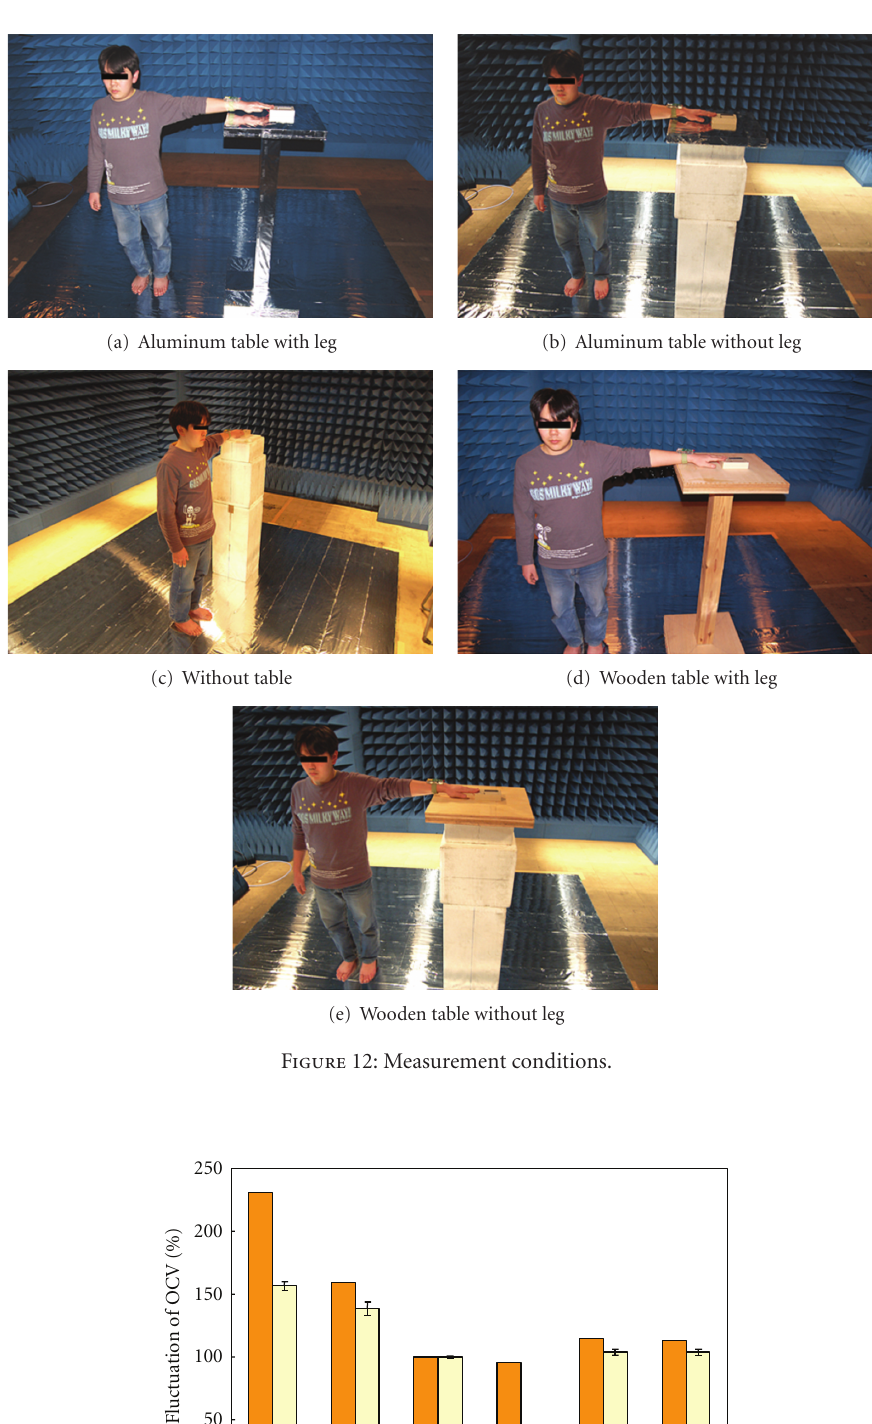
Figure 13: Fluctuations of OCV in each